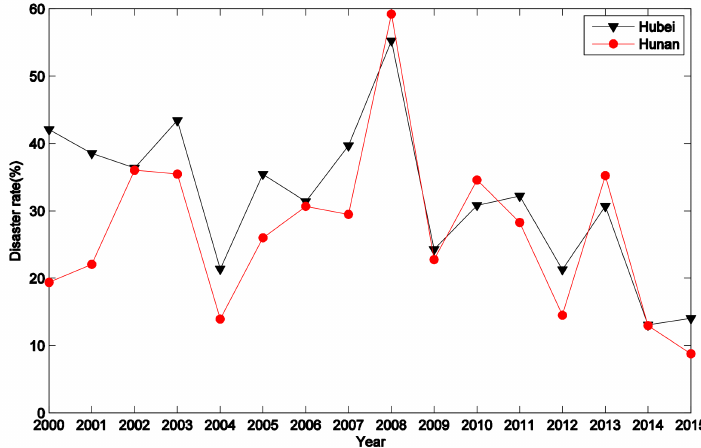
Figure 7. The disaster rate of Hunan Province and Hubei Province from 2000 to